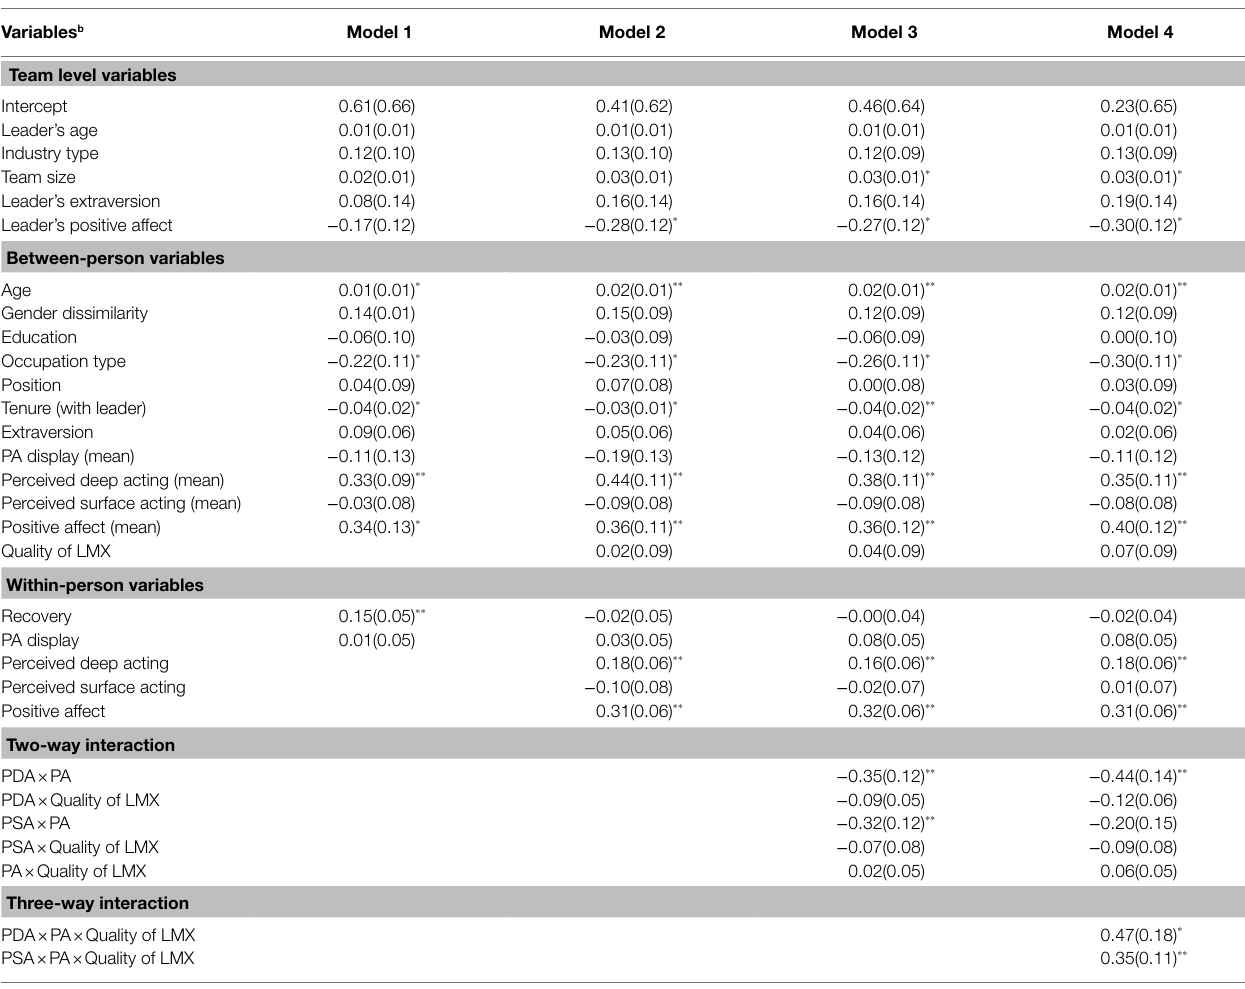
TABLE 3 | Results of HLM regressions: dependent variables are work Engagement.